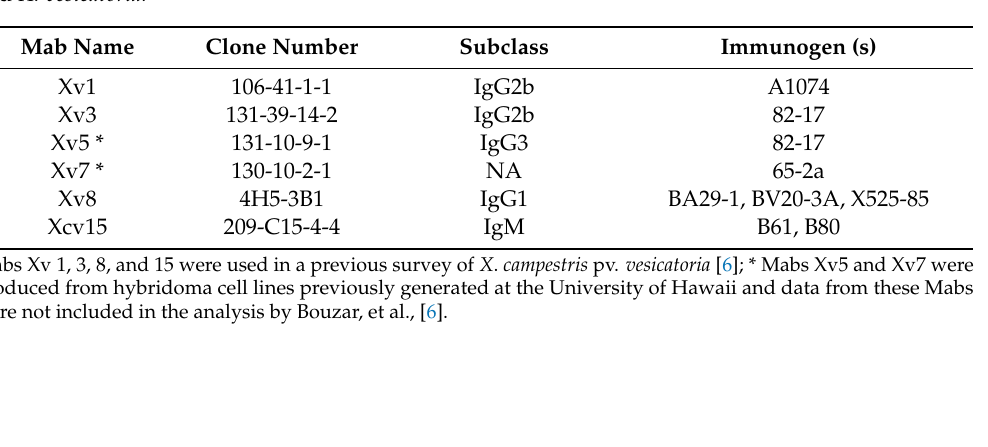
Table 4. Details of the monoclonal antibodies (Mabs) used to characterize Xanthomonas euvesicatoria and X.